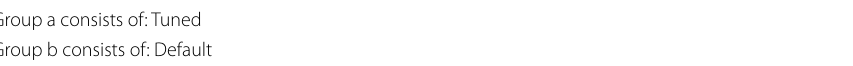
Table 41 HSD test groupings after ANOVA of AUC for the hyperparameters factor